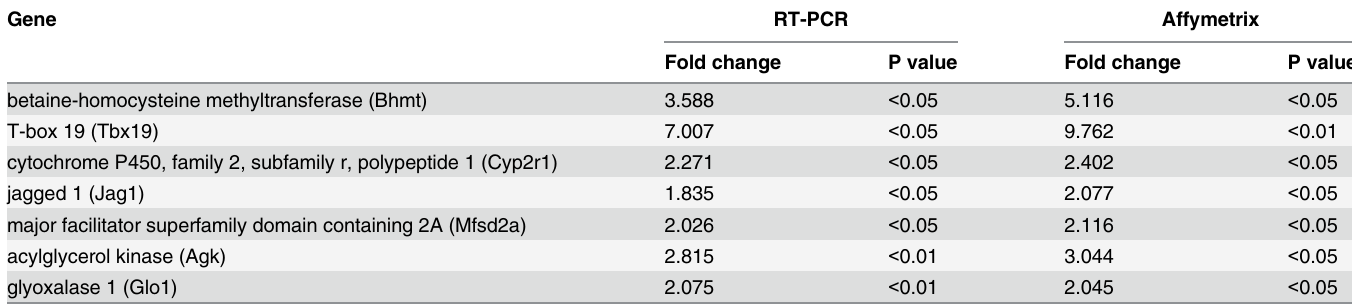
Table 3. Independent validation by real-time PCR of 6 genes significantly altered in the liver of D-galactose mice.